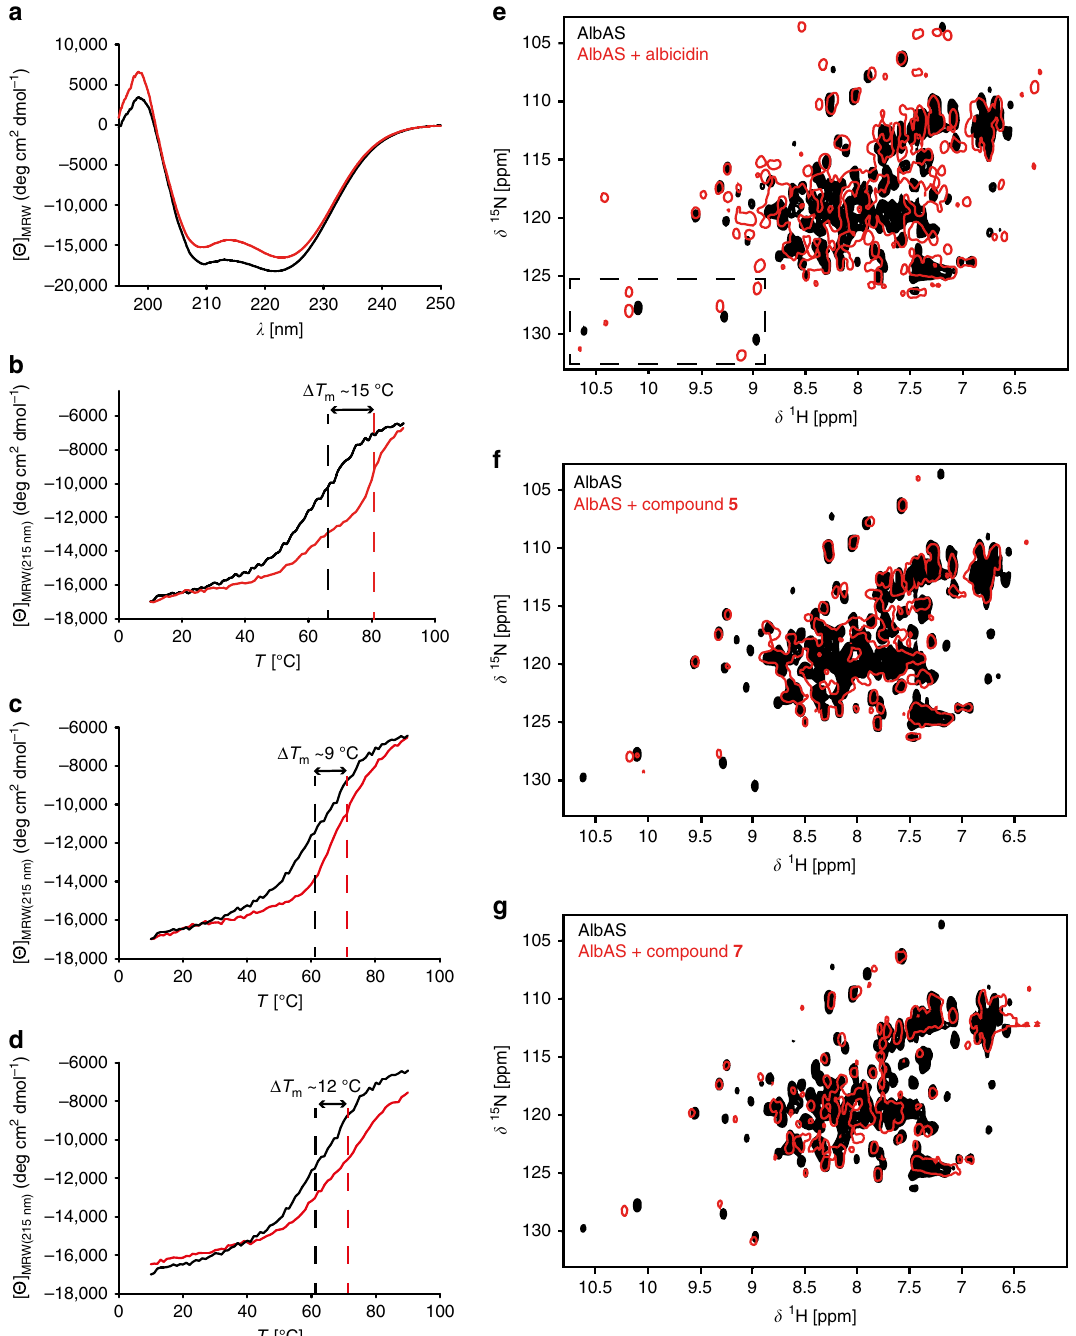
Fig. 3 Impact of albicidin binding on structure and stability of AlbAS. a Far-UV CD spectra of AlbAS in the absence (black) or presence (red) of albicidin (molar ratio 1.5:1 albicidin:AlbAS) at 21 °C. b – d CD-detected thermal unfolding of AlbAS in the absence (black) or presence (red) of albicidin, compound 5 , or compound 7 . T m values are indicated by dashed lines. For the overlay, the [ Θ ] MRW(215nm) signals of AlbAS – albicidin and AlbAS – compound 5 were scaled to that of AlbAS alone using a factor of 1.157 and 1.091, respectively. e – g Overlay of 1 H- 15 N HSQC NMR spectra of AlbAS in the absence (black) or presence (red) of albicidin, compound 5 , or compound 7 , respectively. CD experiments were performed once. NMR experiments with the AlbAS – albicidin complex were performed fi ve times and a representative spectrum is shown in e . NMR experiments using albicidin derivatives were conducted